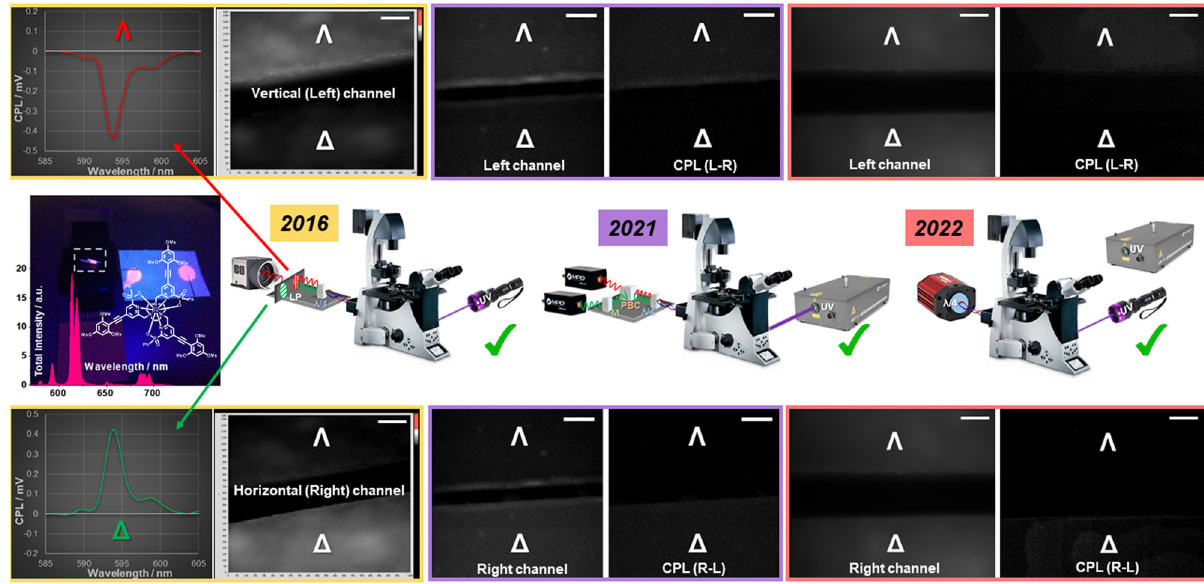
Fig. 8 | Chronological evolution and schematic summary of CPL microscopy and the associated chiroptical separator layouts. (2016) The fi rst epi- fl uorescencemicroscopecapableofchiropticalseparationofleft-andright-handed CPL using a quarter wave plate (QWP) and orthogonally pre-aligned linear polari- sers (LP). Identical results were recorded using fi xed LP and orthogonally aligned QWPpositions.(2021)Theworld ’ s fi rstlaserscanningconfocalmicroscopecapable of simultaneous dual channel EDCC imaging using a QWP, achromatic broad wavelength (400 – 800nm) beam splitter cube and two LP assisted (horizontaland